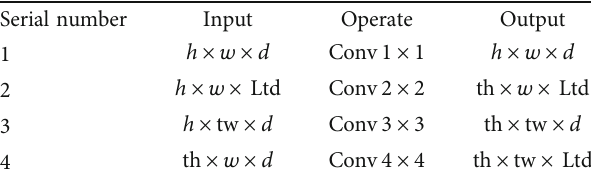
Table 1: Bottleneck